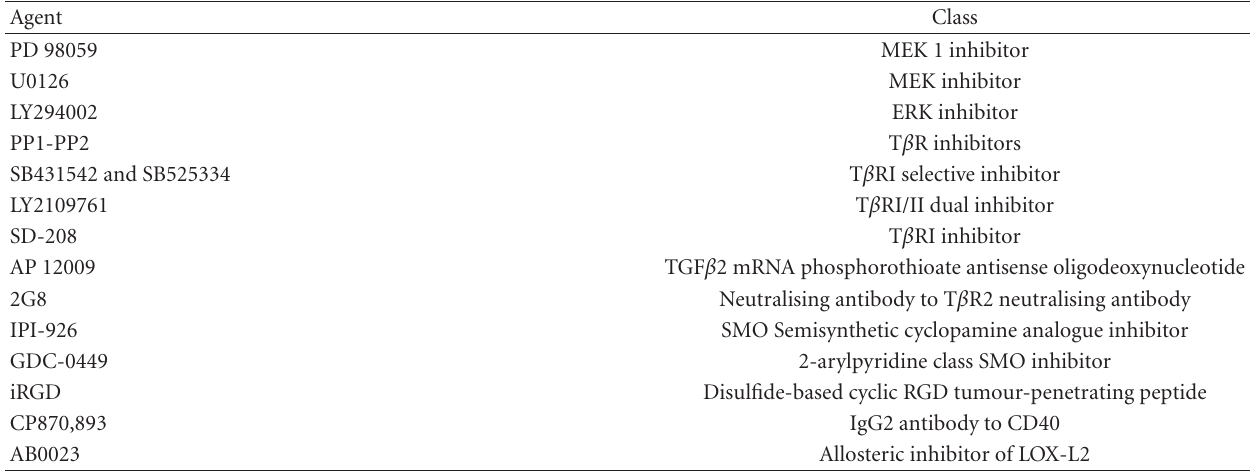
Table 1: Classification of antidesmoplastic